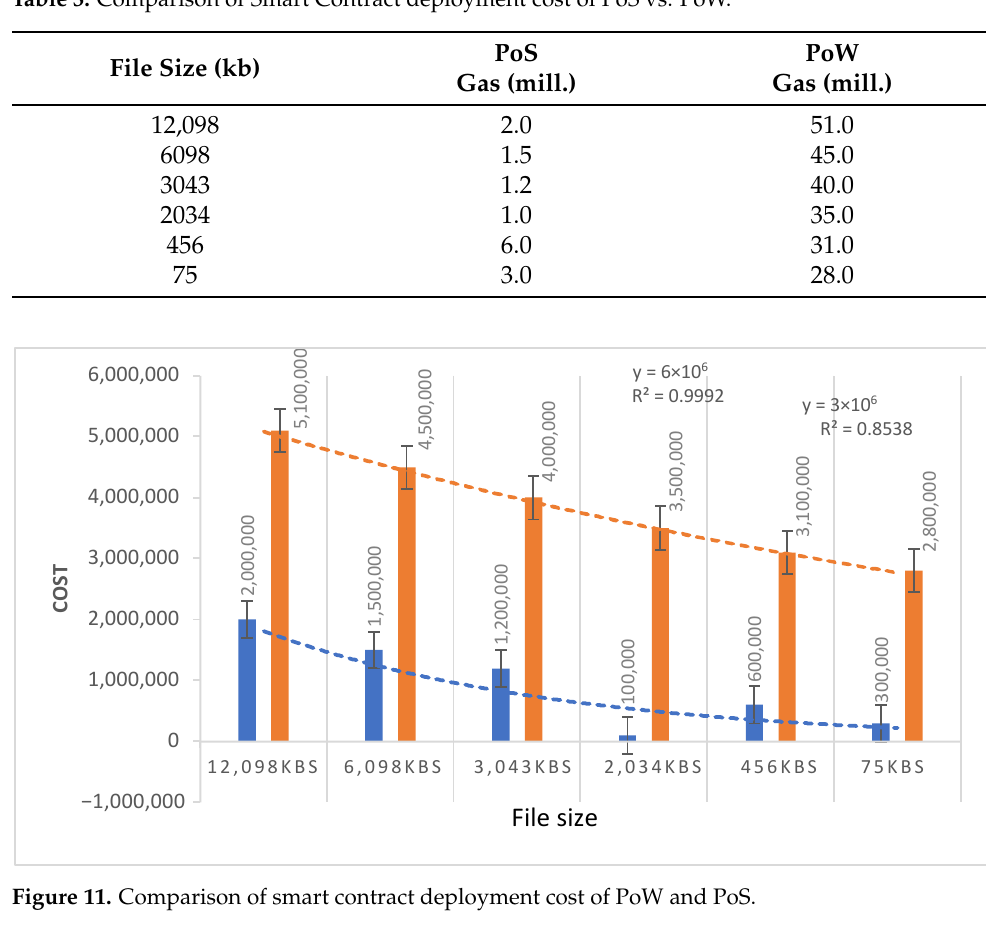
Table 3. Comparison of Smart Contract deployment cost of PoS vs. PoW.